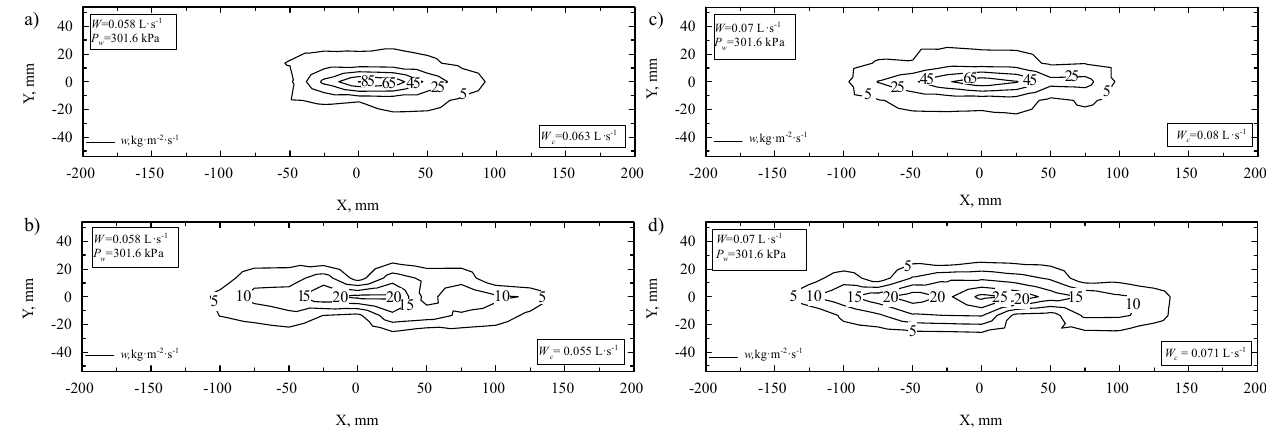
Figure 3. Effect of operating distance on impingement density ( a ) and ( b ) Lechler nozzle 632.604 z = 0.137 m and 0.25 m, respectively. ( c ) and ( d ) Lechler nozzle 632.644 z = 0.15 m and 0.25 m, respectively.